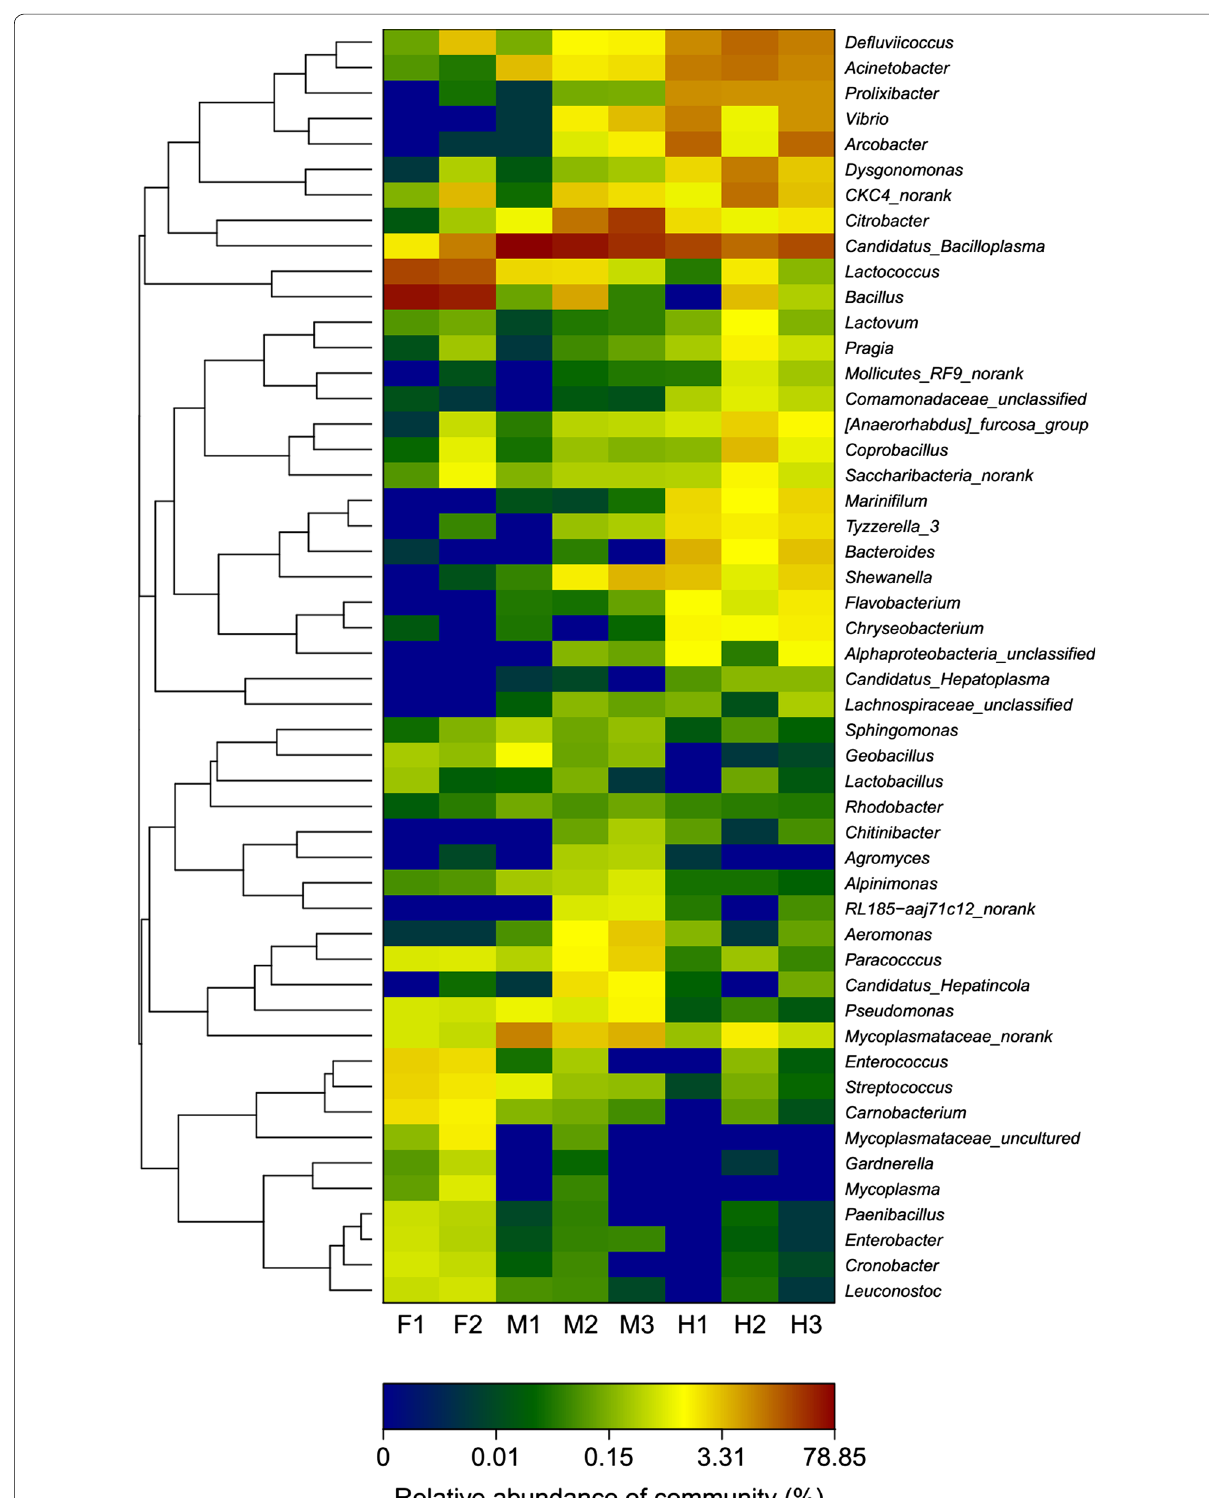
Fig. 1 Heatmap of the dominant digestive flora at the genus level. F foregut, M midgut, H